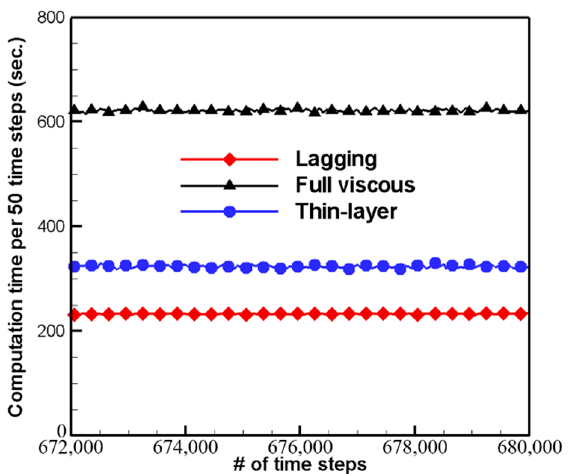
Figure 17. Comparison of required computational time per 50 time steps for three viscous cases.